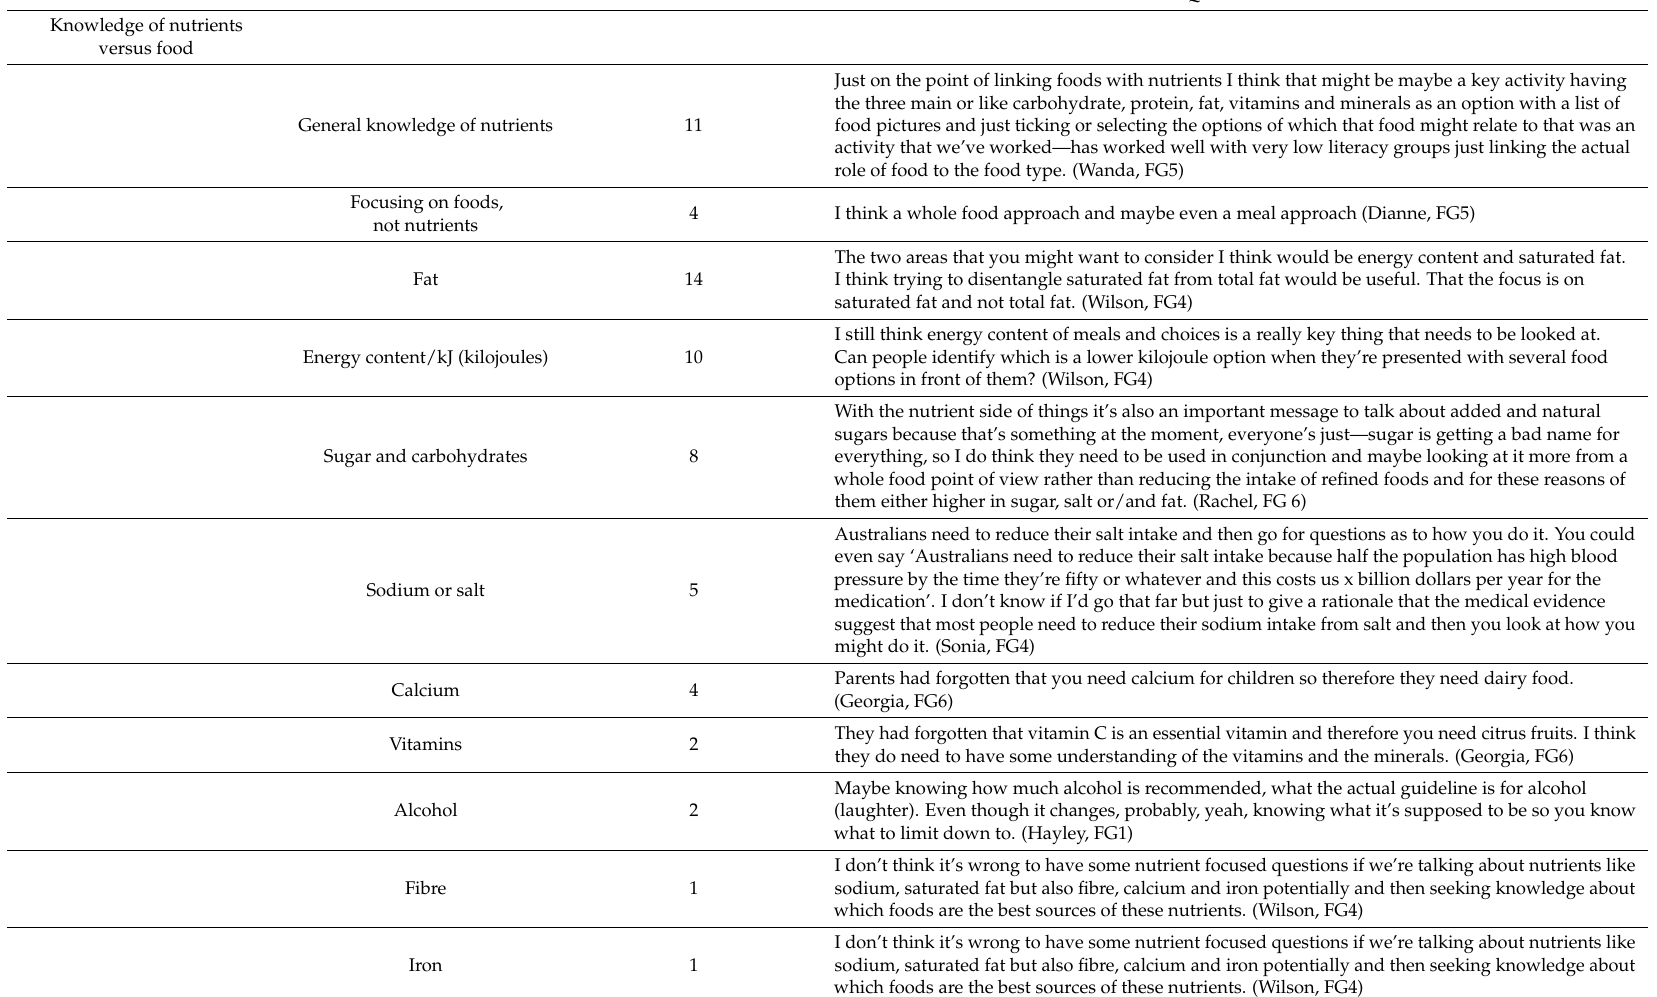
Table 3. Example quotations on areas to assess nutrition